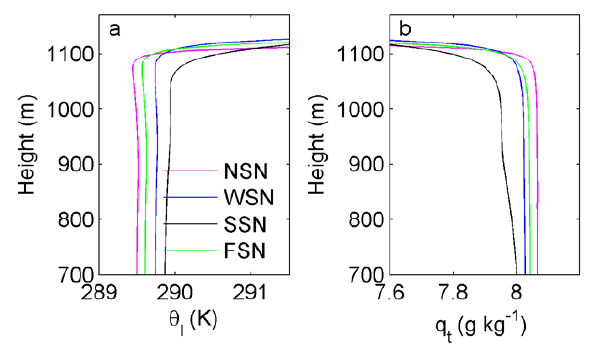
Fig. 10. Mean profiles for no-solar simulations. (a) ¯ θ l ; and (b) ¯ q t